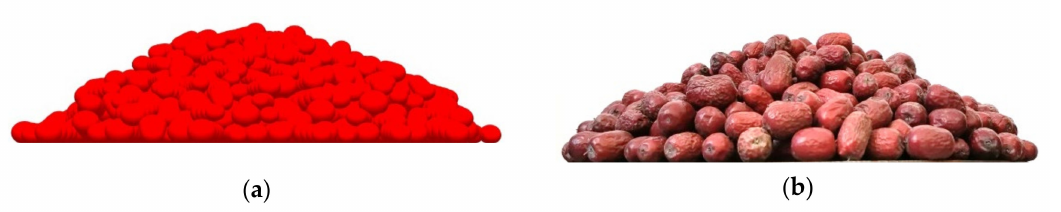
Figure 7. The angle of repose results; ( a ) simulation test angle of repose, ( b ) physical test angle of